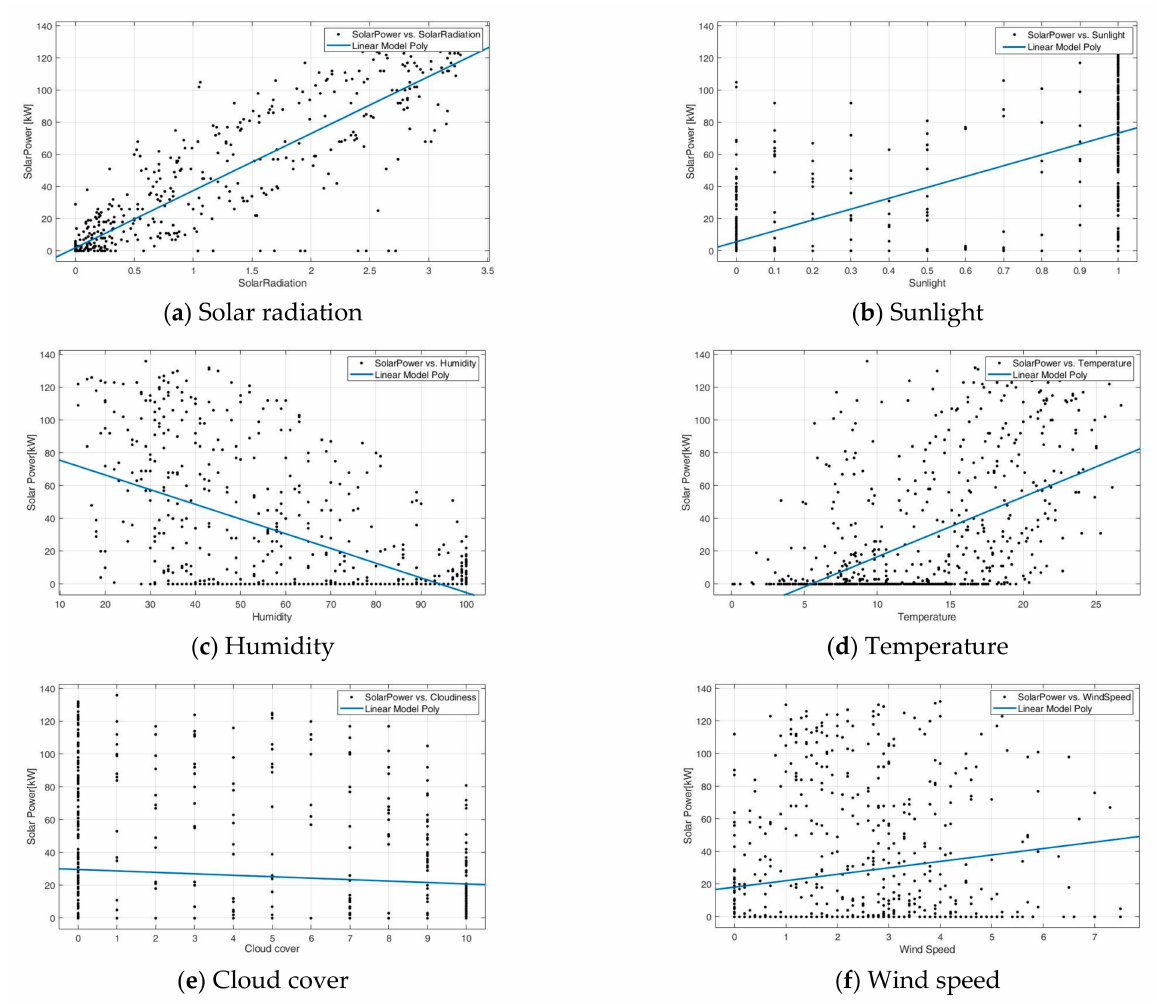
Figure 2. Scatterplots of solar power vs. ( a ) solar radiation (w/m 2 ), ( b ) sunlight, ( c ) humidity (%), ( d ) temperature ( ◦ C), ( e ) cloud cover, and ( f ) wind speed